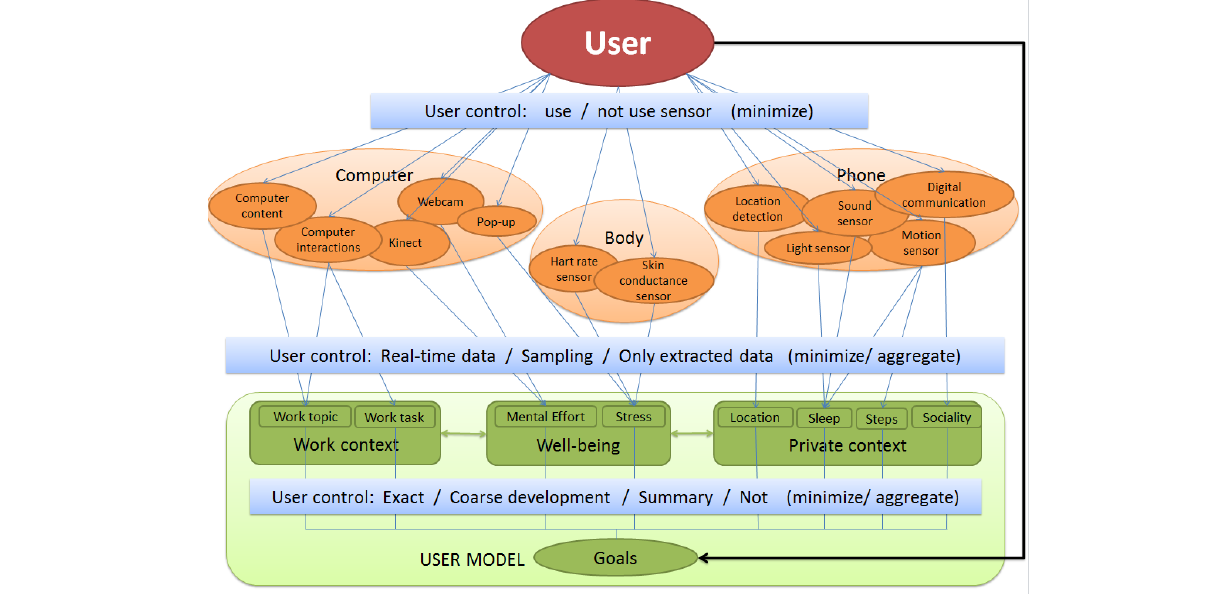
Figure 8. Overview of the system and its user's model, which holds information on the users work context and